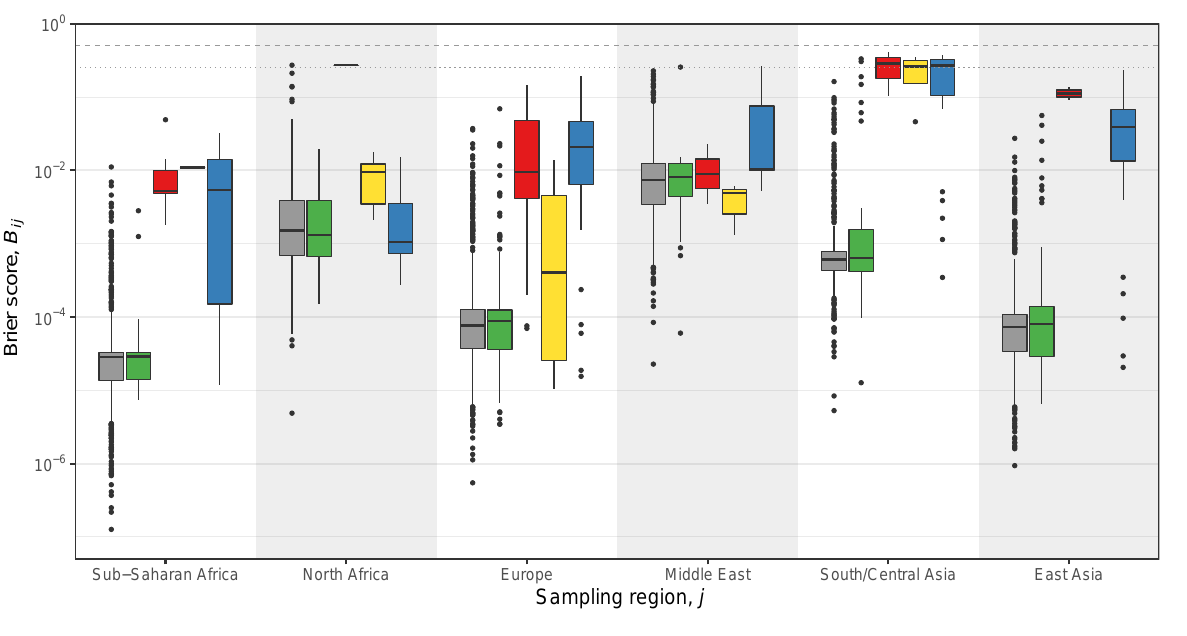
Figure 3. Boxplots of the Brier scores, B ij , with K = 4 in the STRUCTURE analysis and j running through the metapopulations of [58]. Reference: Samples constituting the metapopulations (and used to calculate ¯ q j ). Concordant: A sample is accepted in the metapopulation coinciding with its sampling region (with a likelihood value significantly larger than any other metapopulation). Discordant: A sample is accepted in a metapopulation different than its sampling region (with a likelihood value significantly larger than any other metapopulation). Ambiguous: A sample’s likelihood value is not significantly different in two or more of the accepted metapopulations. Rejected: A sample is rejected in all metapopulations. The concordant test samples (green) have similar Brier scores as those of the reference samples (grey). Discordant samples (red) tend to have the largest Brier scores, followed by the rejected samples (blue) with the ambiguous (yellow) in between (see text for definitions). The horizontal dashed and dotted lines in the top of the plot indicates B ij = 0.5 and 0.25, respectively ([26], inspired by Supplementary Figure